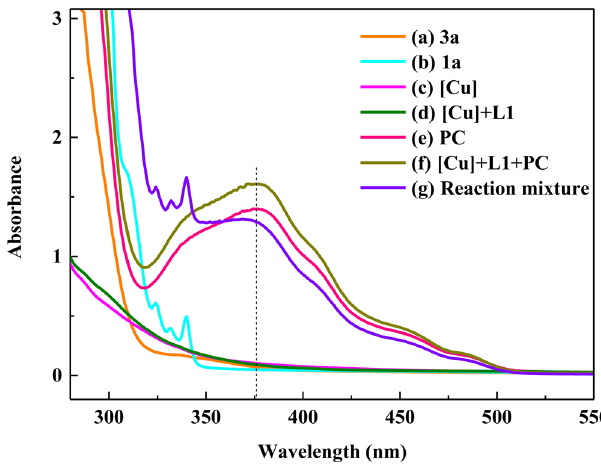
Fig. 2 Absorption spectra. a DMA solution of 3a . b DMA solution of 1a . c DMA solution of Cu(CH 3 CN) 4 PF 6 . d DMA solution of Cu(CH 3 CN) 4 PF 6 / L1 . e DMA solution of fac -Ir(ppy) 3 . f DMA solution of Cu(CH 3 CN) 4 PF 6 / L1 / fac - Ir(ppy) 3 . g Reaction